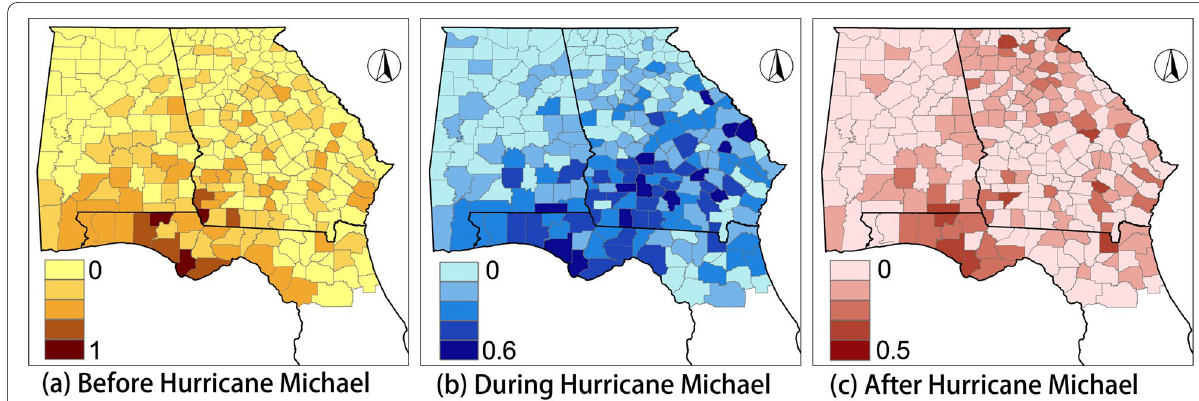
Fig. 4 Spatial distribution of perception-level GSA before, during and after Hurricane